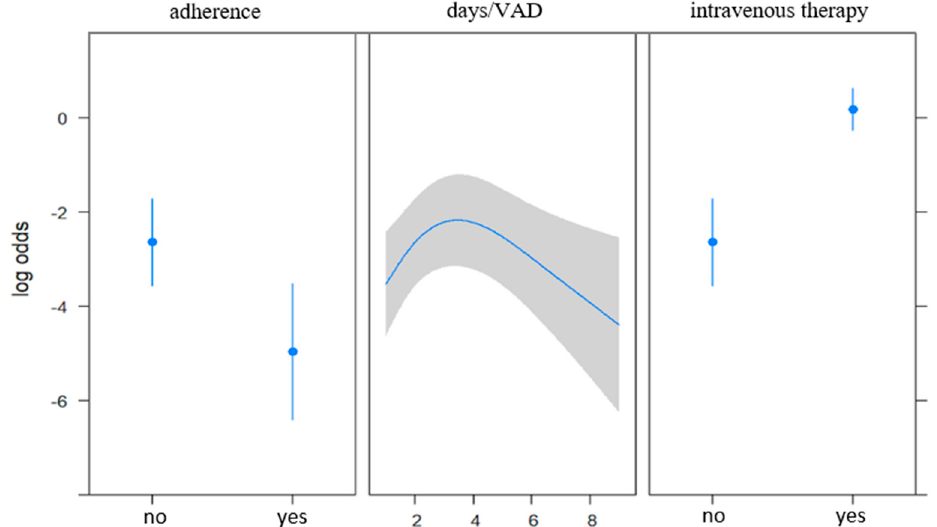
Figure 1. Association between the occurrence of complications and adherence, days/VAD and administration of intravenous therapy. Nonlinearity for days/VAD ( p = 0.0014) was estimated via restricted cubic splines and was adjusted for adherence and administration of intravenous ther- apy. Abbreviation: VAD, vascular access device.